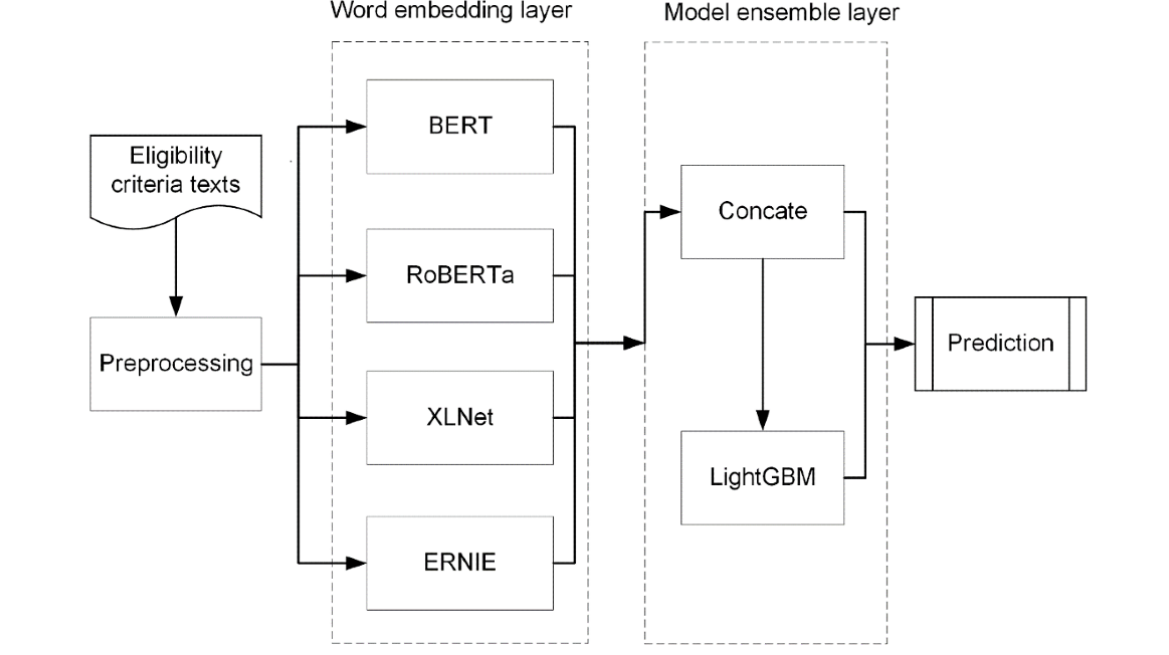
Figure 1. The framework of the proposed model that contains two layers: a word embedding layer consisting of 4 pretrained models (BERT, XLNet, ERNIE, and RoBERTa); and a model ensemble layer containing LightGBM, used to learn information by combining the outputs of the 4 pretrained models. BERT: Bidirectional Encoder Representations from Transformers; ERNIE: Enhanced Representation through Knowledge Integration; LightGBM: Light Gradient Boosting Machine; RoBERTa: A Robustly Optimized BERT Pretraining